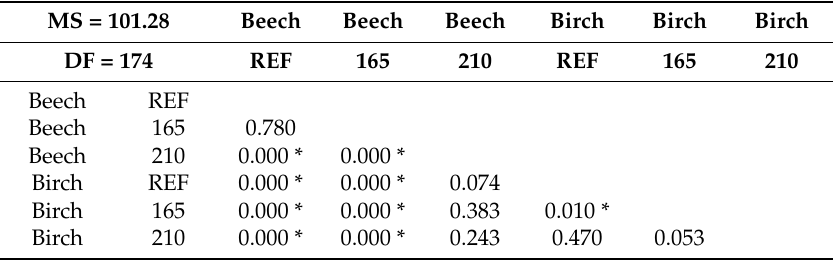
Table A7. Duncan’s Multiple Range Test for Hardness LR.